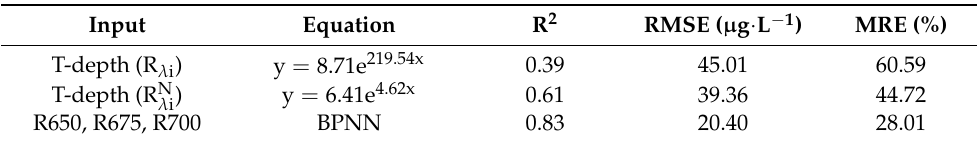
Table 5. The T-depth and back-propagation neural network (BPNN) (R650, R675, R700) models for Chl-a concentration.